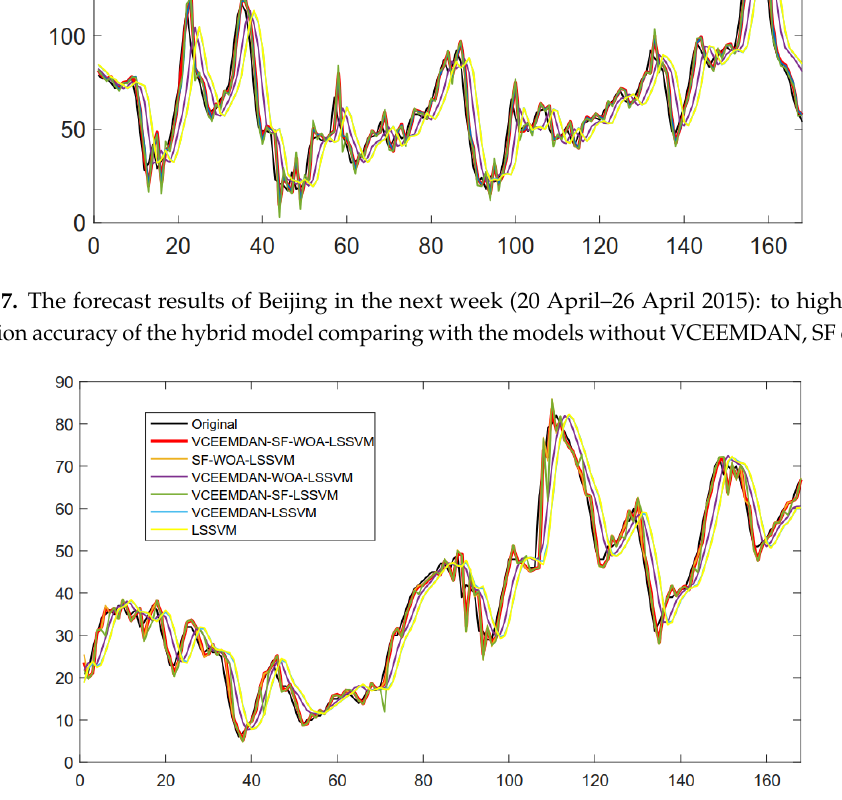
Figure 8. The forecast results of Yibin in the next week (20 April–26 April 2015): to highlight the prediction accuracy of the hybrid model comparing with the models without VCEEMDAN, SF or